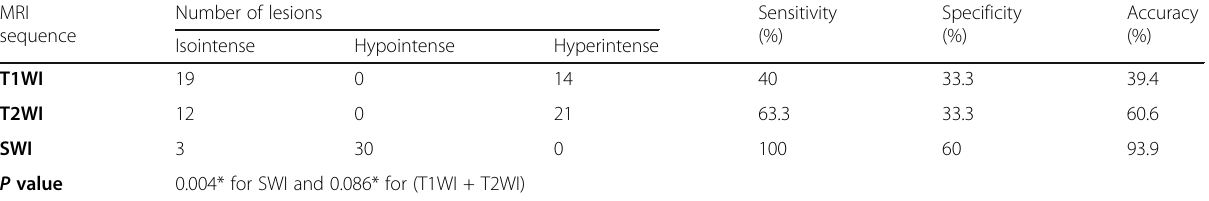
Table 2 T1WI, T2WI, and SWI lesion signal intensity in the cavernoma (number of patients = 13 and number of lesions = 33) MRI sequence